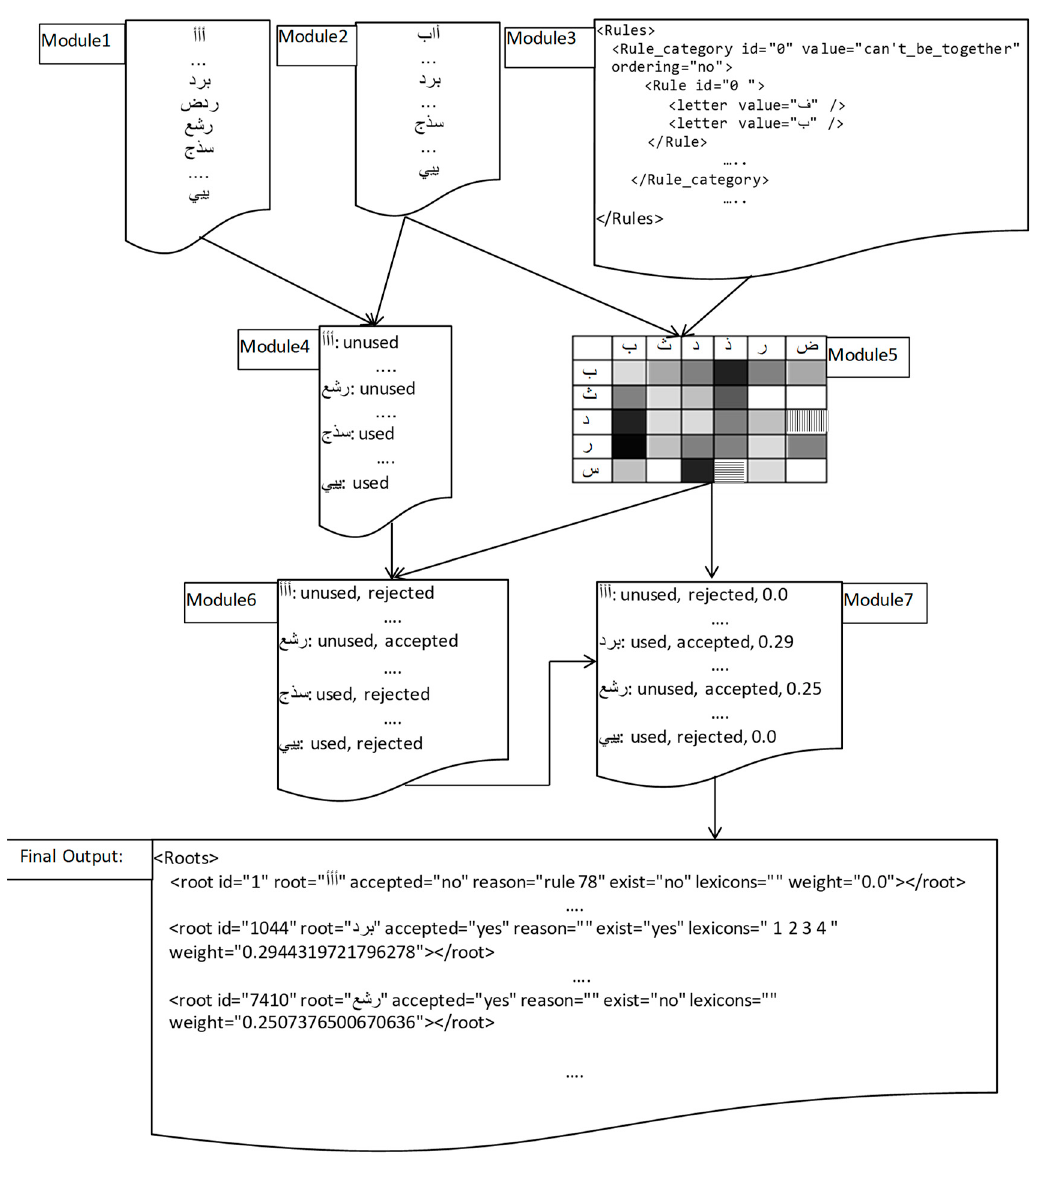
Figure 2. Modules Output Samples.